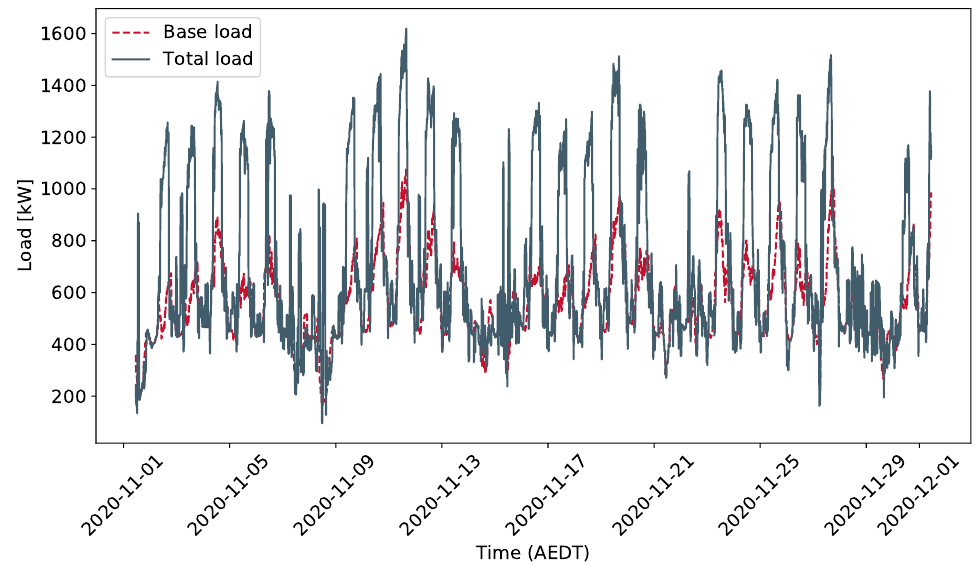
Figure 9. Real base load and total load resulting from the schedule for problem instance